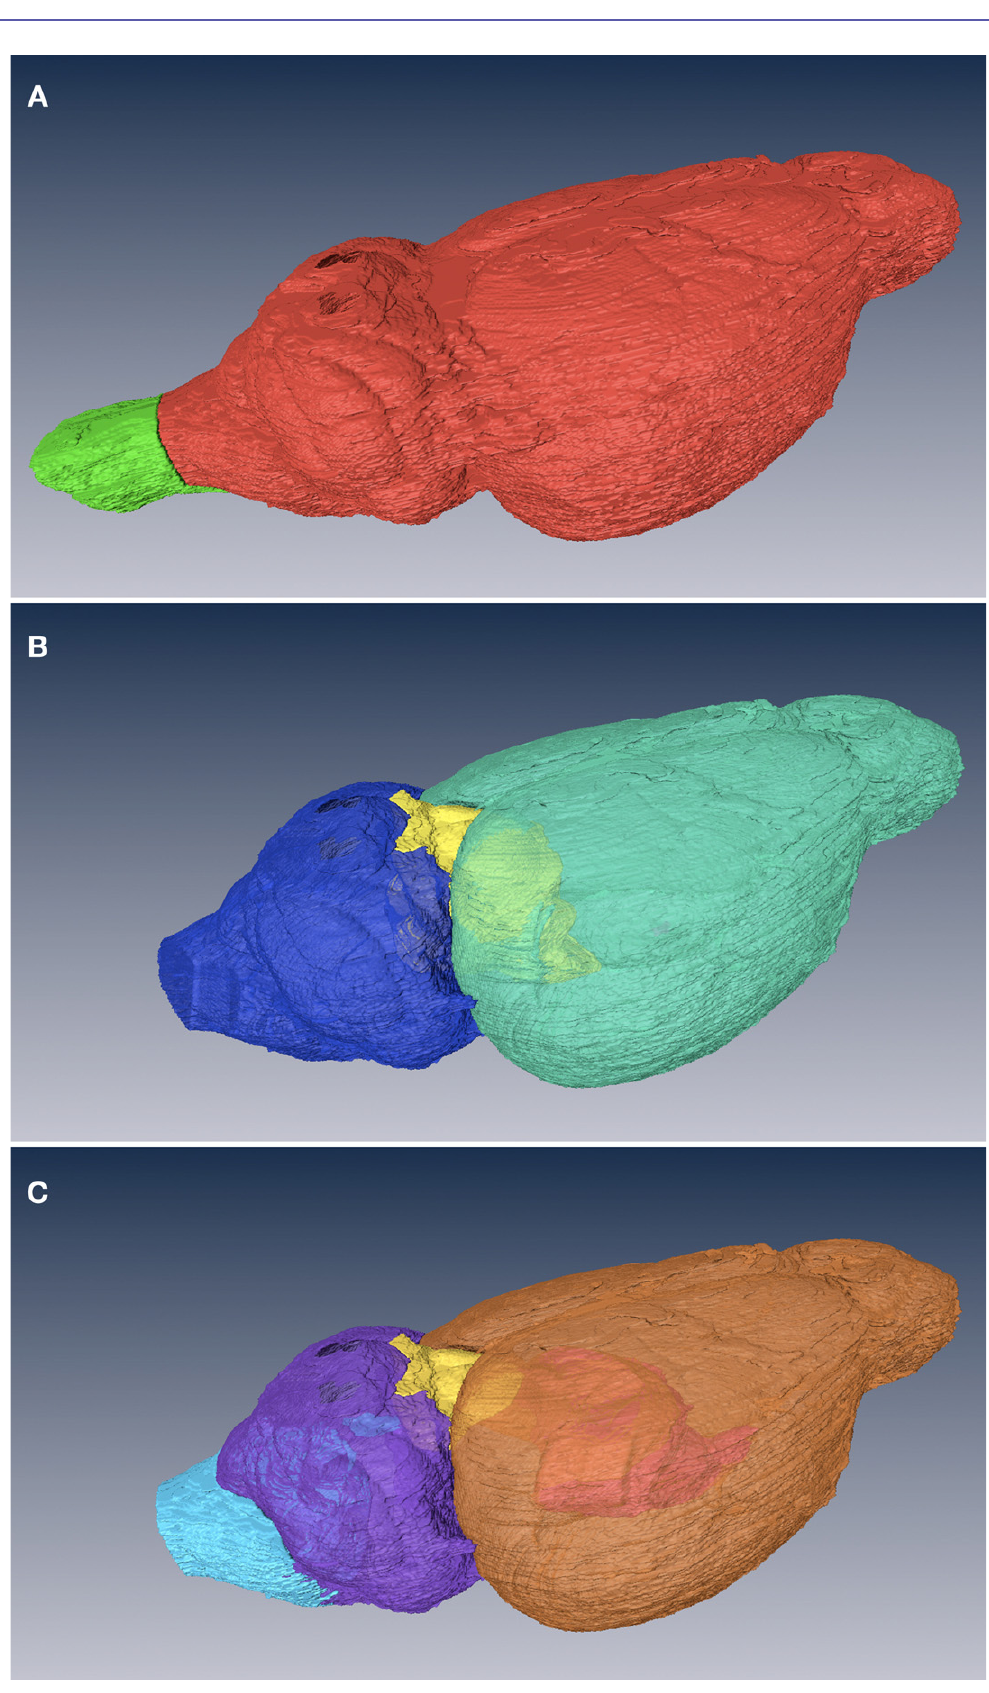
Figure 2 | Surface views of NeuroNames level 1–3. Level 1 (A) , the coarsest level, subdivides the CNS into brain (red) and spinal cord (green). The brain is further divided in level 2 (B) into forebrain (green), midbrain (yellow), and hindbrain (blue). In level 3 (C) , the divisions are telencephalon (orange), diencephalon (pink), tectum (yellow), metencephalon (purple), and medulla oblongata (light